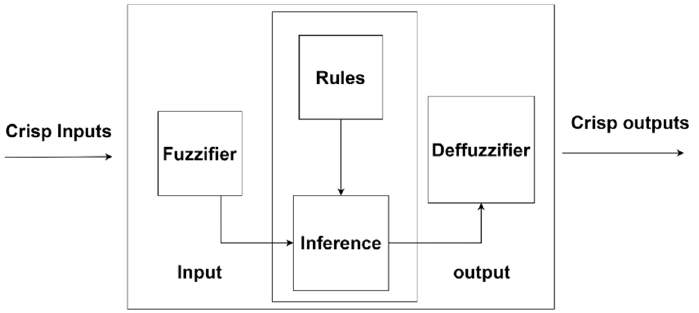
Figure 1. Architectural block diagram for the purposed Fuzzy Logic